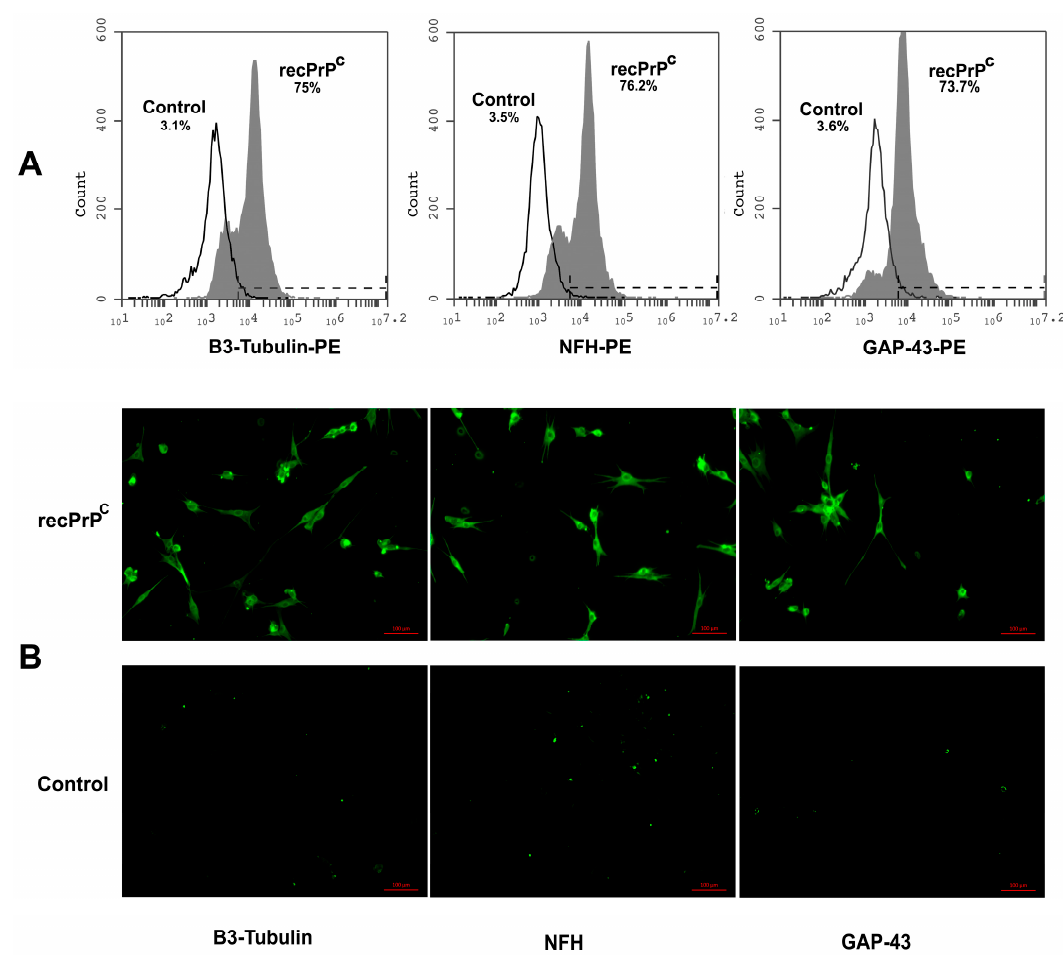
Figure 4. E ff ect of recPrP C on expression of neuronal markers GAP-43, NFH and B3-Tubulin. hDPSCs, untreated or treated with recPrP C for 14 days, were analyzed by flow cytometry and immunofluorescence analysis using anti-NFH, Anti-B3-Tubulin and anti-GAP-43. ( A ) Flow Cytometry. Histograms represent log fluorescence vs. cell number, gated on cell population of a side scatter / forward scatter (SS / FS) histogram. Cell number is indicated on the y-axis and fluorescence intensity is represented on the x-axis. Each panel was compared with the corresponding secondary antibody as negative control. A representative experiment among 3 is shown. ( B ) Immunofluorescence analysis. Alternatively, hDPSCs were analyzed by immunofluorescence analysis using anti-B3-Tubulin, anti-NFH and anti-GAP-43 and observed with a Zeiss Axio Vert. A1 fluorescence microscope (Zeiss, Oberkochen, Germany). Scale bars, 100 µ